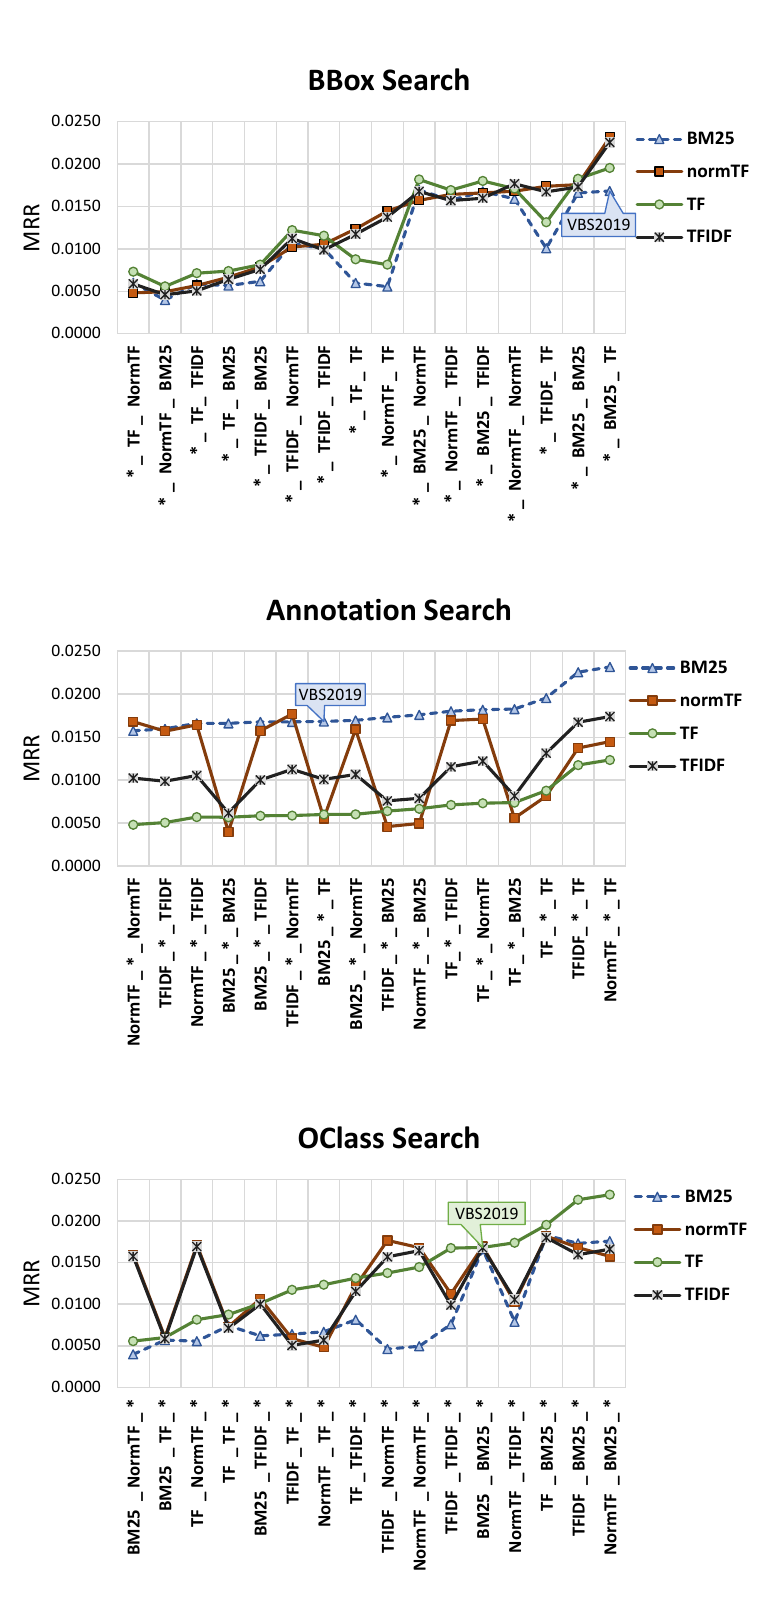
Figure 12. MRR varying the ranker for each search operation. The * stand in for the ranker depicted on chart. A graph callout is used in each chart to mark the point corresponding to the combination used at